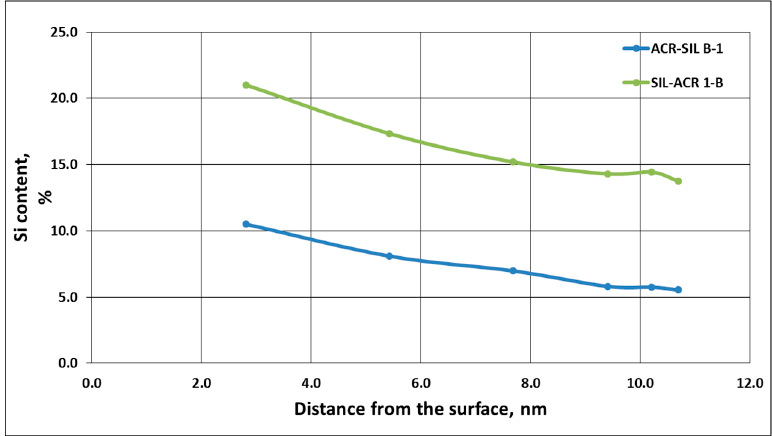
Figure 11. Decrease in Si content with distance from coating surface determined by XPS for coatings obtained from SIL-ACR and ACR-SIL dispersions.